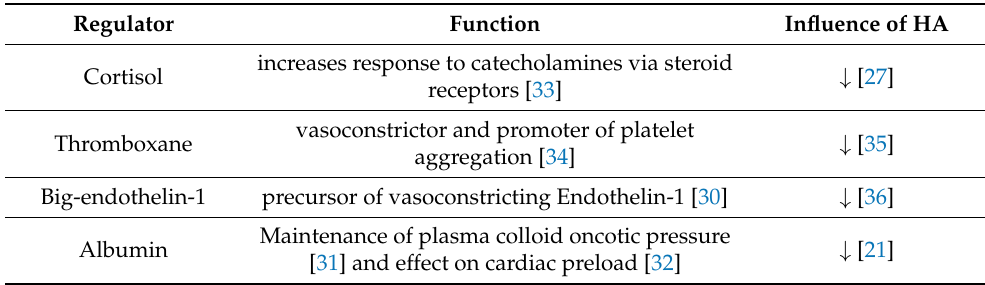
Table 6. Regulators of vasoconstriction reduced by hemoadsorption (HA) and potentially linked to postoperative